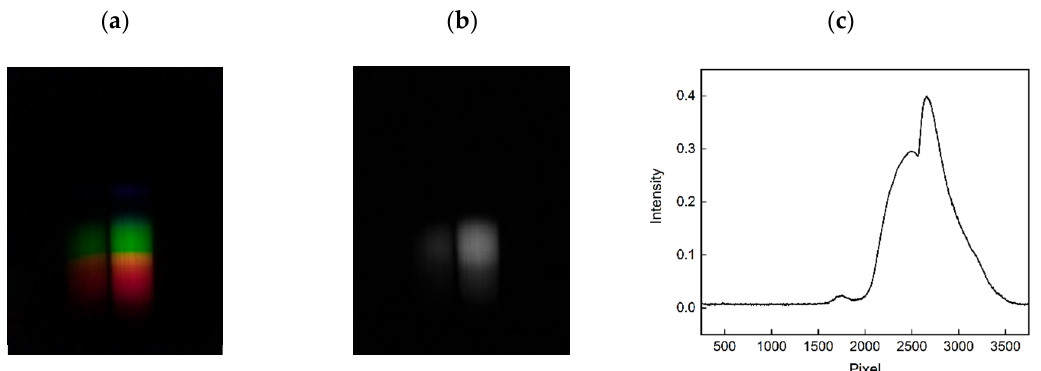
Figure 3. Detected spectra of the two SPR sensors using photo images from the smartphone ( a ) and subsequent grey-scaling ( b ). The grey-scaled image was then used to obtain the intensity values per column and thus to obtain the sensor spectra ( c ).